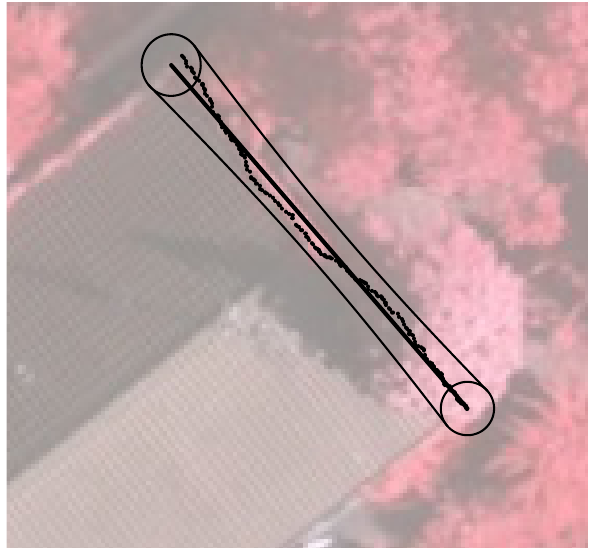
Figure 1. Interactive drawing of a straight line segment: A best- fitting straight line (solid) approximates the tracked positions of the input device (dots). The confidence region of the straight line has a hyperbolic shape, whereas ellipses depict the positional un- certainty of the two